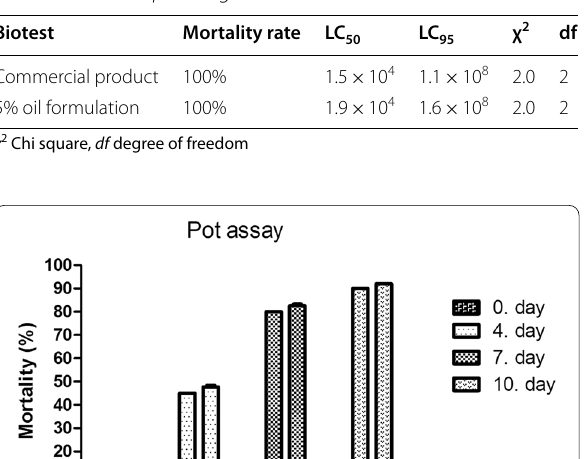
Table 1 Mortality values of HearNPV products against 3rd instar larvae of Helicoverpa armigera